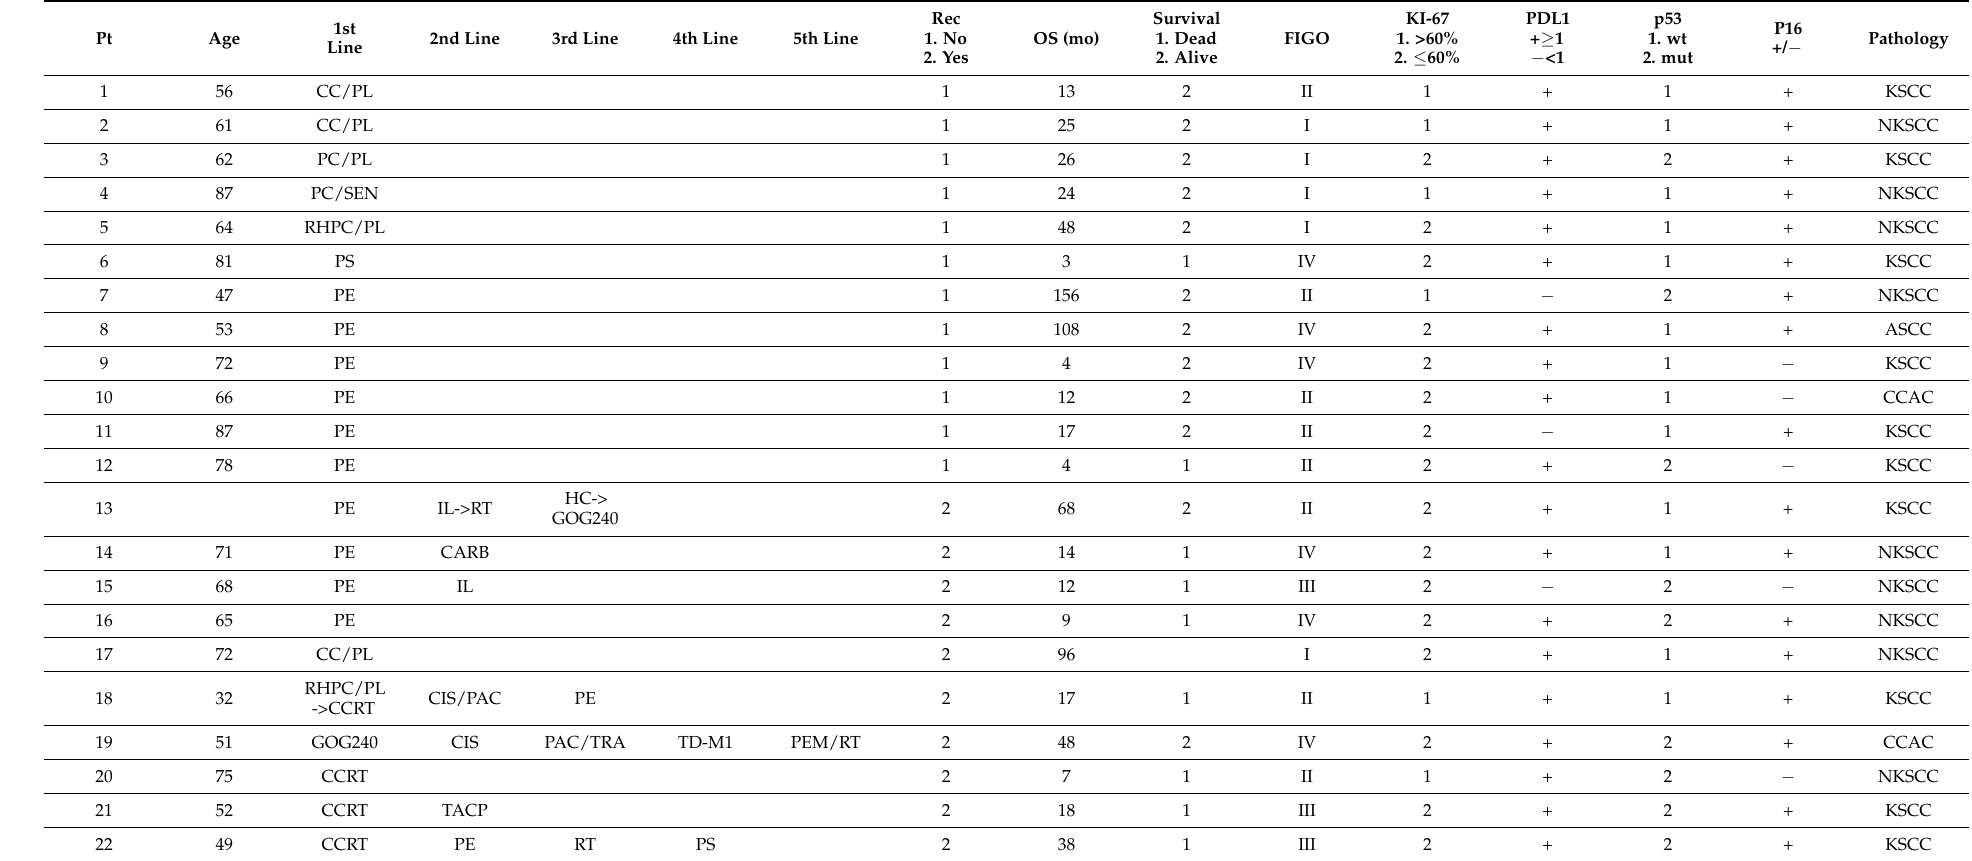
Table 1. Therapeutic course, immunohistochemistry, pathology, and